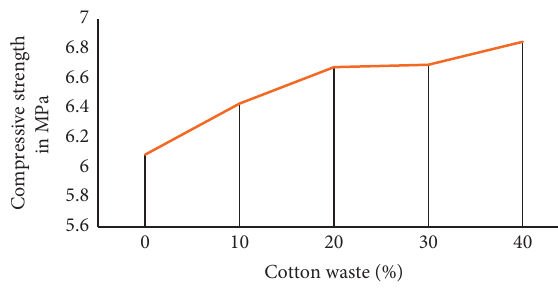
Figure 9: Effect of cotton microdust ratio on brick strength. Table 6: ANOVA analysis of compressive strength of